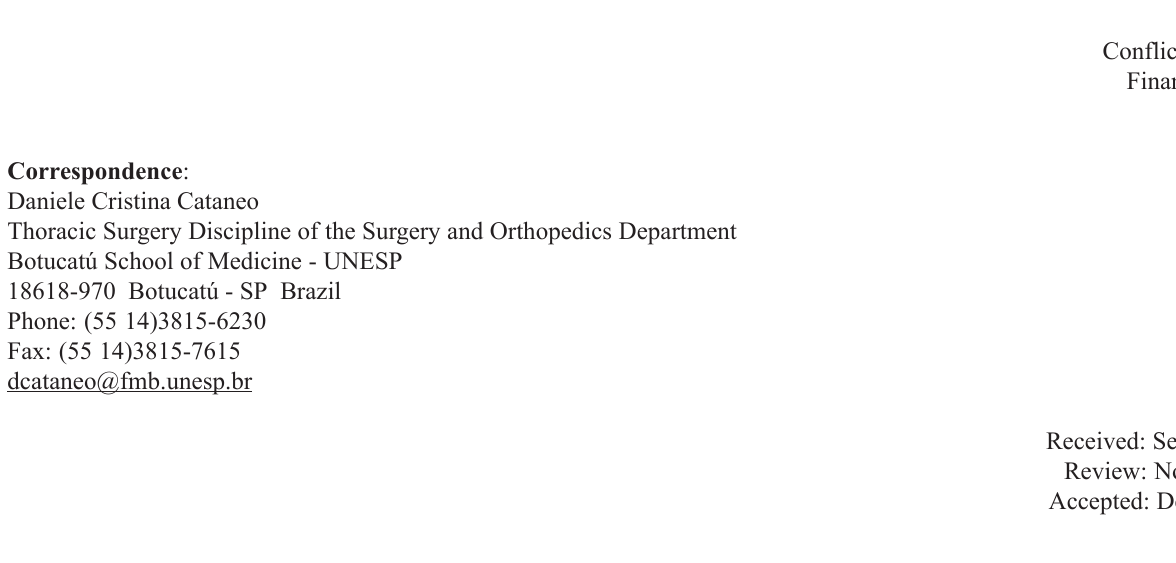
20. Brunelli A, Refai M, Xiumé F, Salati M, Sciarra V, Socci L, Sabbatini A. Performance at symptom-limited stair-climbing test is associated with increased cardiopulmonary complications, mortality, and costs after major lung resection. Ann Thorac Surg.